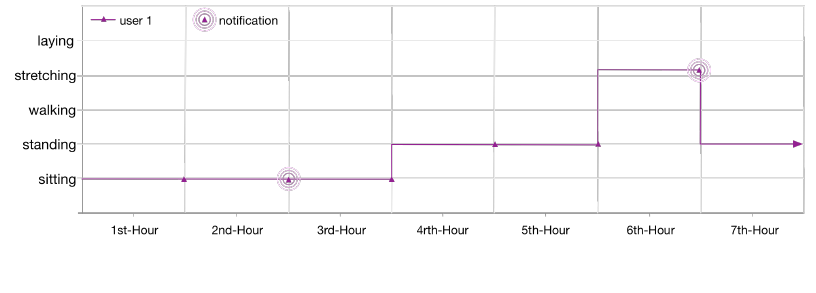
Figure 12. User 1, 7 h lifelog.